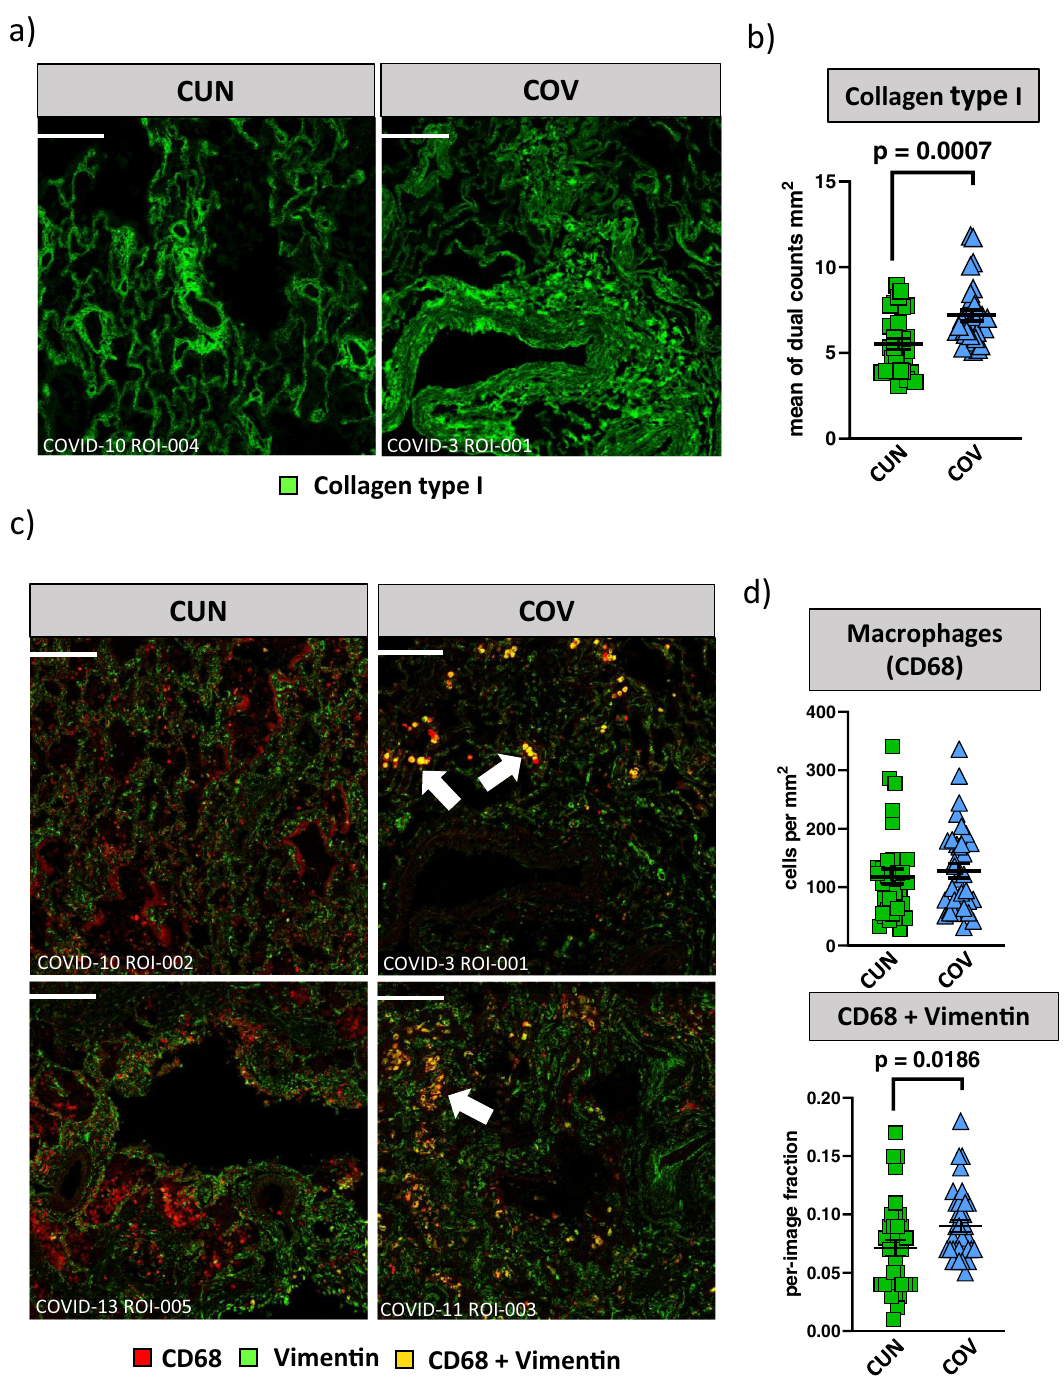
Fig. 7 Spatial landscape of lung tissue from young and aged COVID-19 patients. a Collagen type I distribution in lung images of CUN ( n = 3; ROI = 31) and COV ( n = 3; ROI = 30). Scale bar 200 µ m. The sample name and the region of interest (ROI) are indicated. b Collagen type I mean intensity in images from CUN and COV patients. The central bar represents the mean ± SEM. Mann – Whitney U- test was used for the statistical analysis. Exact p -value is reported in the fi gure. c Spatial distribution of macrophages expressing CD68 (red dots) and activated macrophages simultaneously expressing CD68 and vimentin (yellow dots). Scale bar 200 µ m. The sample name and the region of interest (ROI) are indicated. d Abundance of macrophages (top) and the fraction of activated macrophages (bottom) in lung images of CUN and COV patients. The central bar represents the mean ± SEM. Mann – Whitney U -test was used for the statistical analysis. Exact p -value is reported in the fi gure.